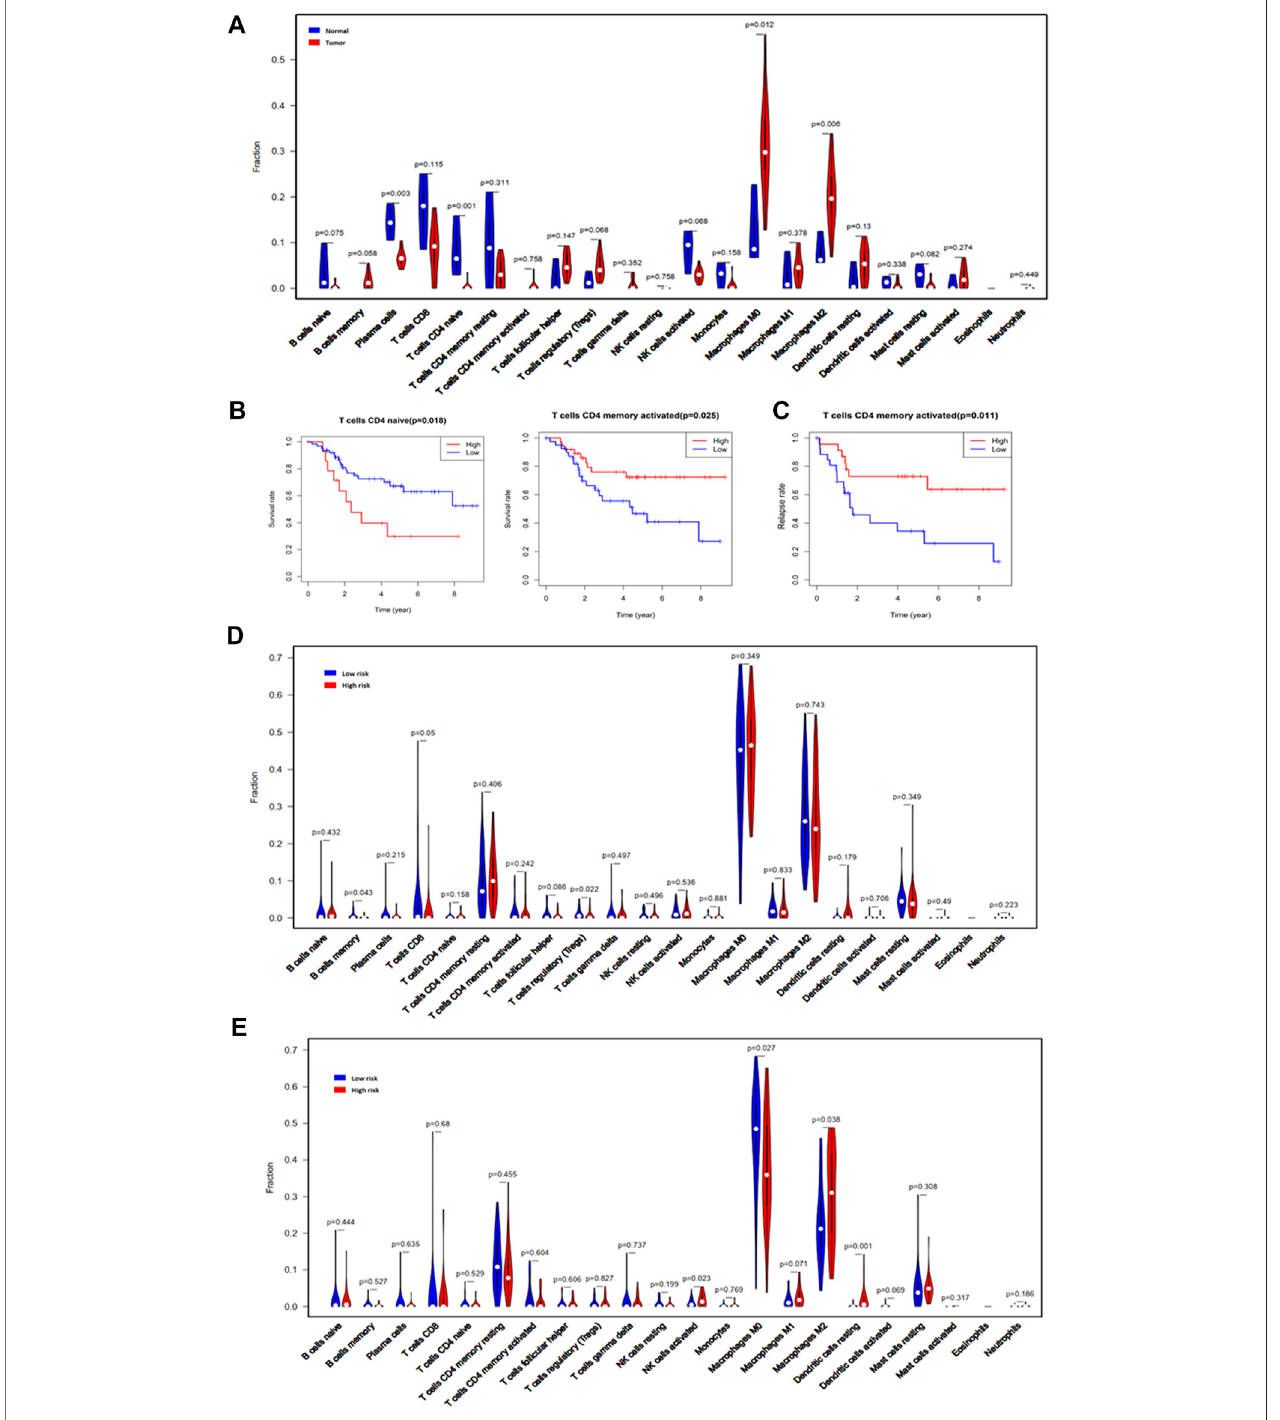
FIGURE 6 | Tumor-in fi ltrating immune cells based on CIBERSORT. (A) Violin plot comparing the proportions of TIICs in normal bone tissues and osteosarcoma tissues in GSE16088. (B) The OS analysis of naïve and memory-activated CD4 T-cells for the validation cohort (TARGET). (C) The RFS analysis of the memory CD4 T-cells for the validation cohort (TARGET). (D) Violin plot comparing the proportions of TIICs associated with low and high risk scores designated by the OS prediction model for the validation cohort (TARGET). (E) Violin plot comparing the proportions of TIICs associated with the low and high risk scores designated by the RFS prediction model for the validation cohort